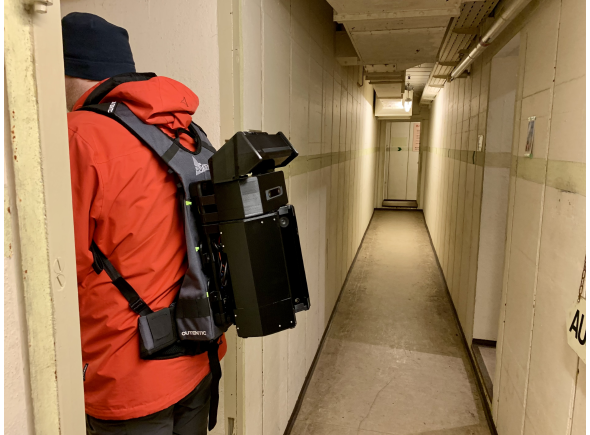
Figure 1. Proposed indoor mapping backpack with four Microsoft Kinect 2 RGB-D cameras and an Intel T265 stereo camera for visual-inertial